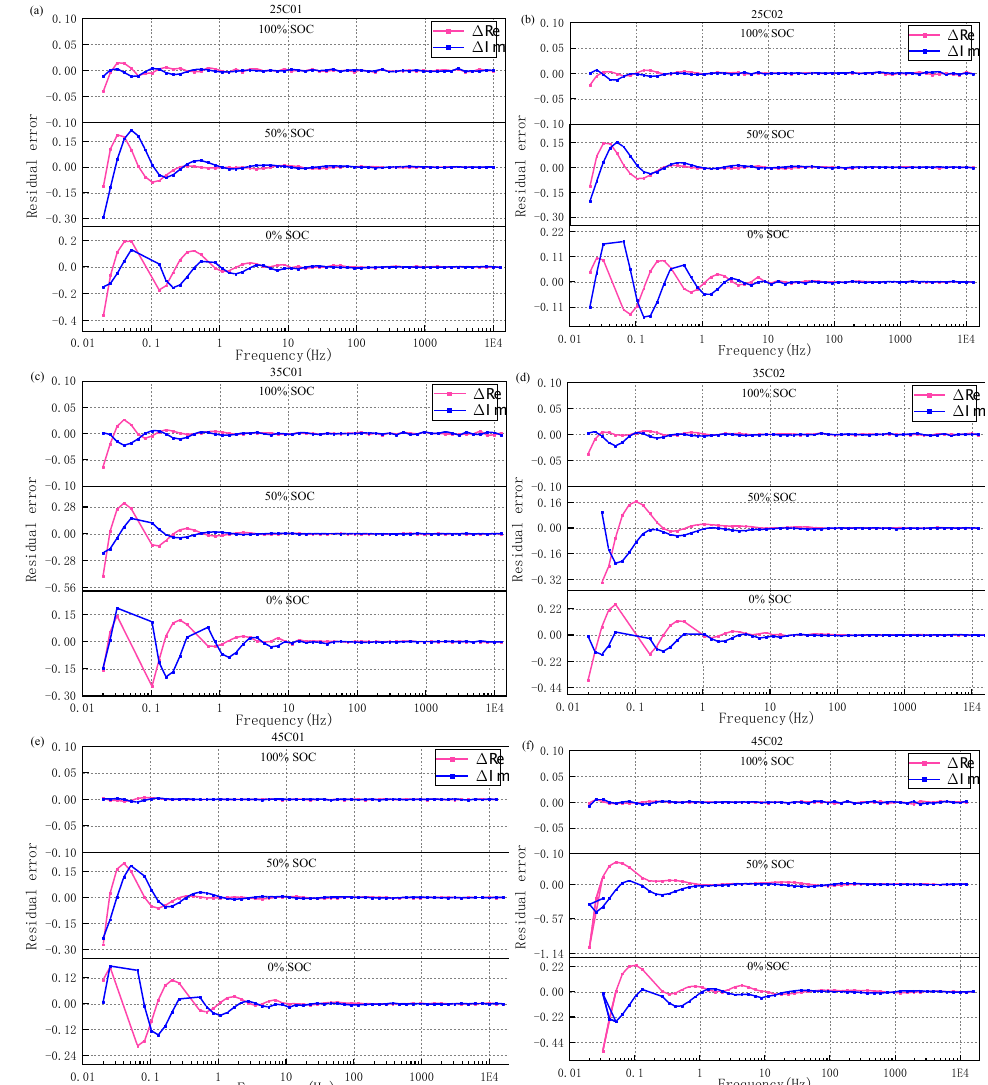
Figure 4. ( a , b ) Residual of EIS at different SOC, 25 °C under Lin − KK test. ( c , d ) Residual of EIS at different SOC, 35 °C under Lin − KK test. ( e , f ) Residual of EIS at different SOC, 45 °C under Lin − KK test. Above all, it indicates that the EIS data at 100% SOC are more consistent with the K − K relationship. Therefore, in order to avoid the effect on the SOH prediction accuracy of LIBs due to the error of EIS data itself. EIS data under 100% SOC were adopted as training